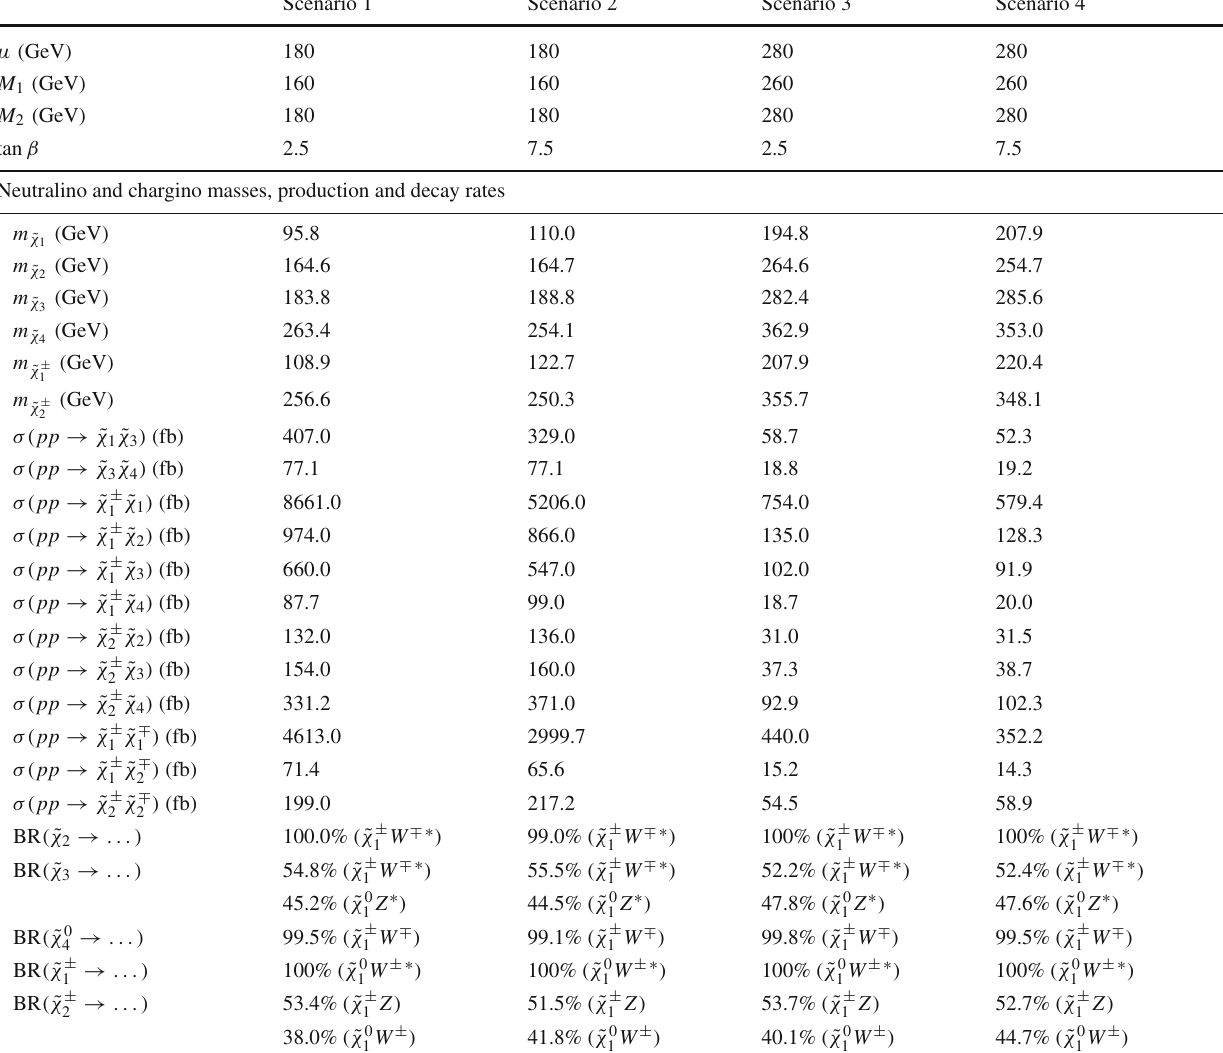
Table 1 A detailed view on two parameter points from the M 125 scenario (scenario 1 and 2), as well as two variations (scenario 3 and 4): relevant parameters for the electroweak sector (top); masses and rates